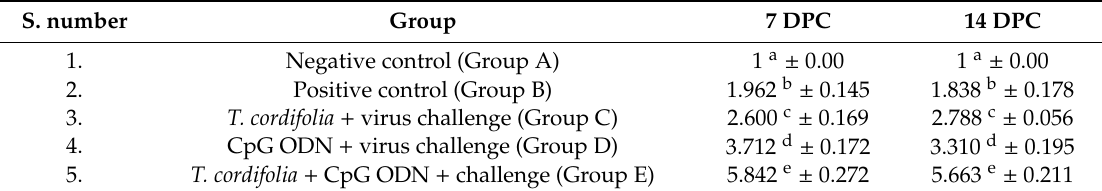
Table 9. Quantitative real time PCR analysis of IL-4 expression in the bursa of Fabricius of chickens challenged with vvIBDV at di ff erent DPC.